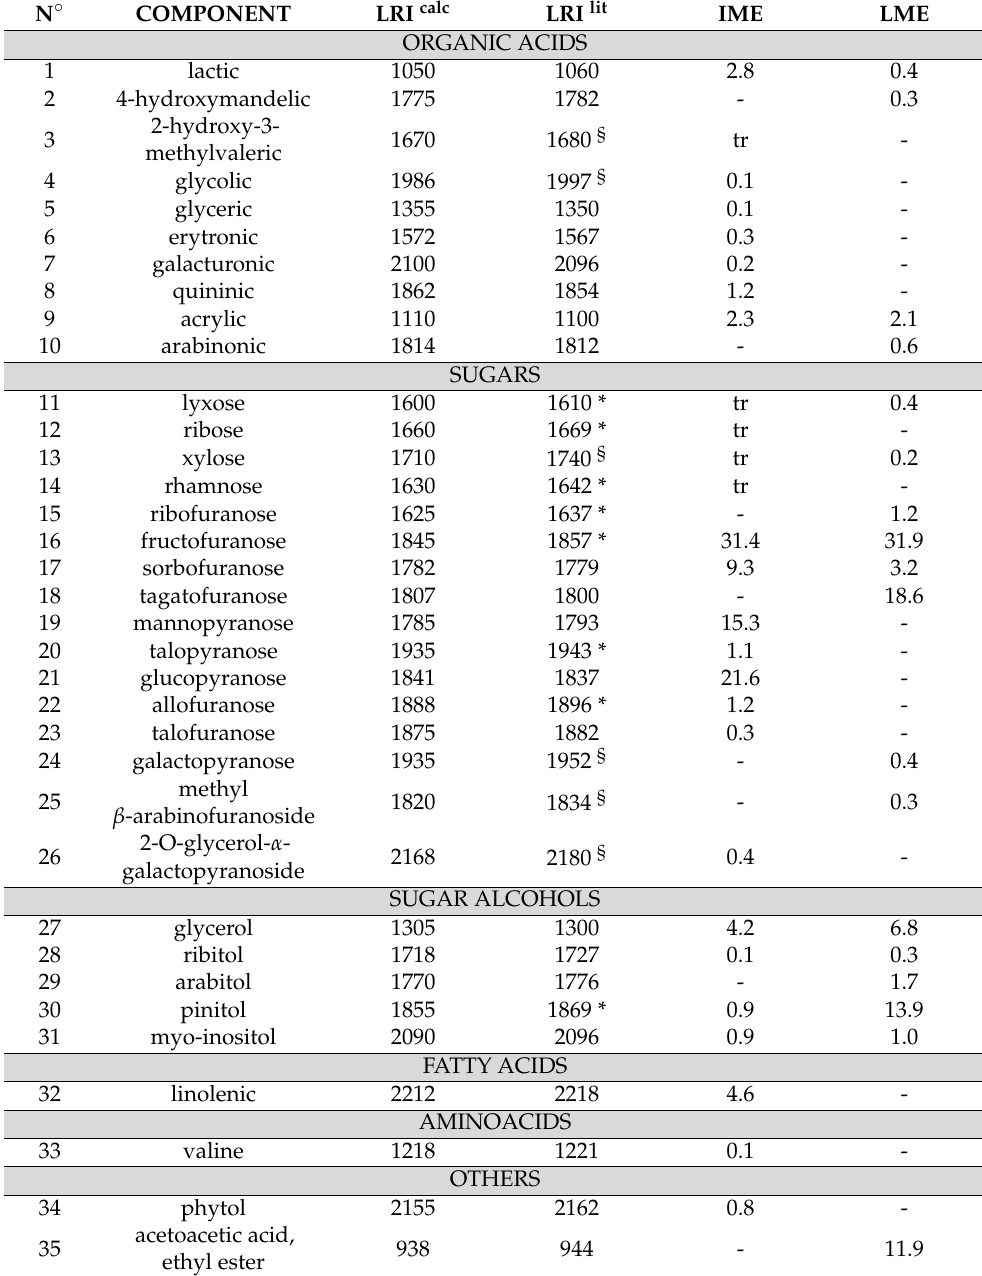
Table 4. Chemical composition (percentage values) of methanolic extracts after derivatization from hops inflorescences and leaves, as determined by